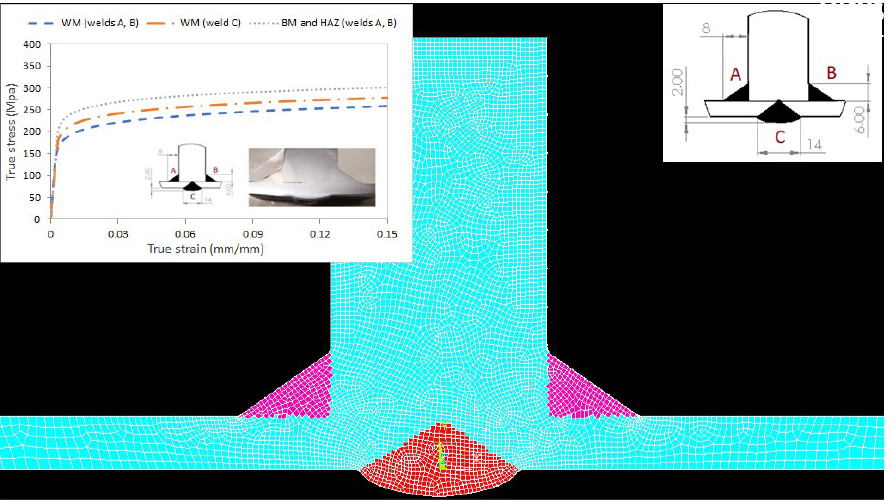
Figure 5. FE model and material